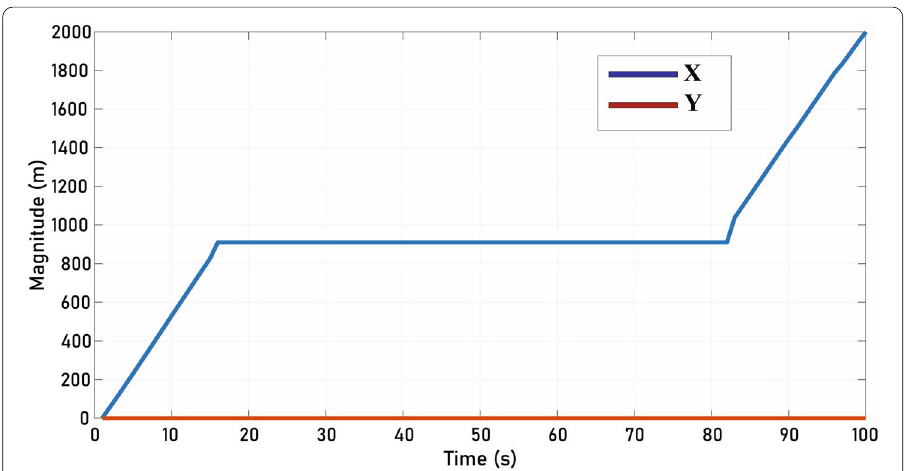
Fig. 10 Optimized trajectory by jointly optimizing power and